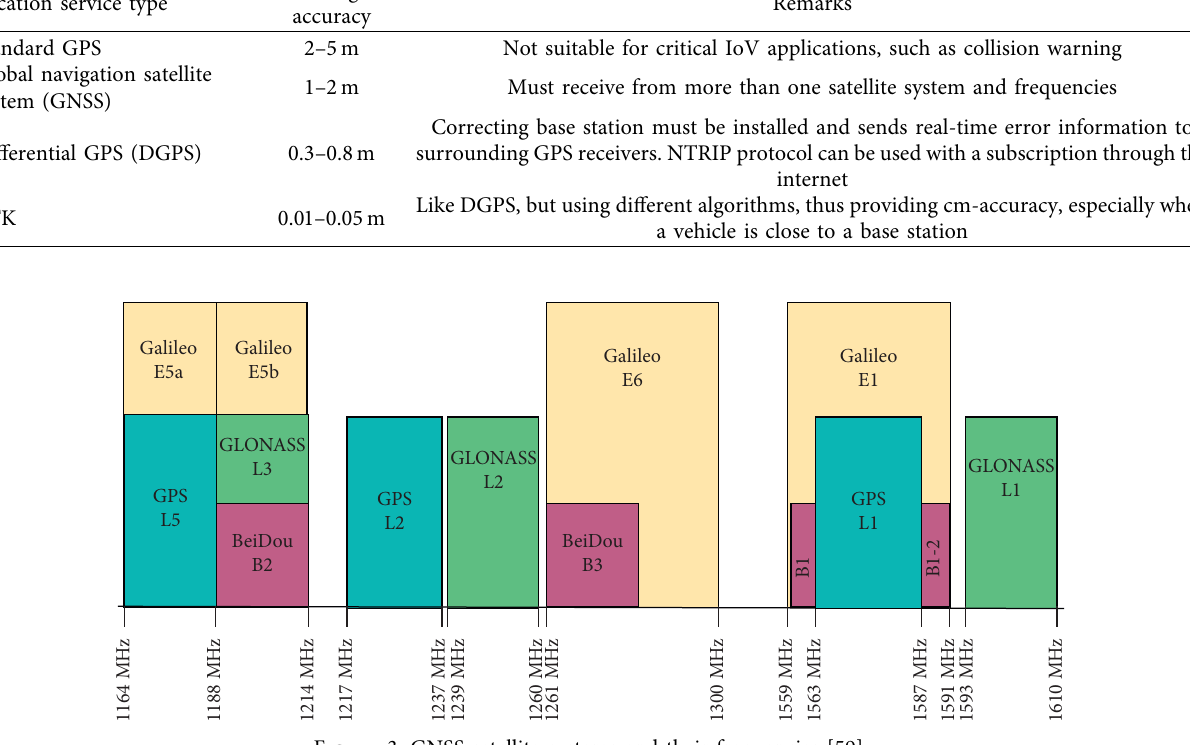
Figure 3: GNSS satellite systems and their frequencies [59].